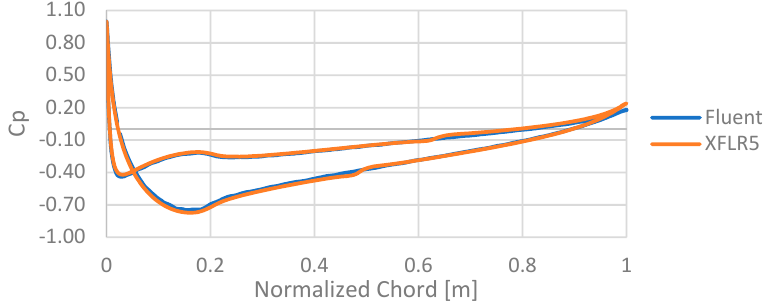
Figure 6. Pressure coefficient plot for numerical validation.